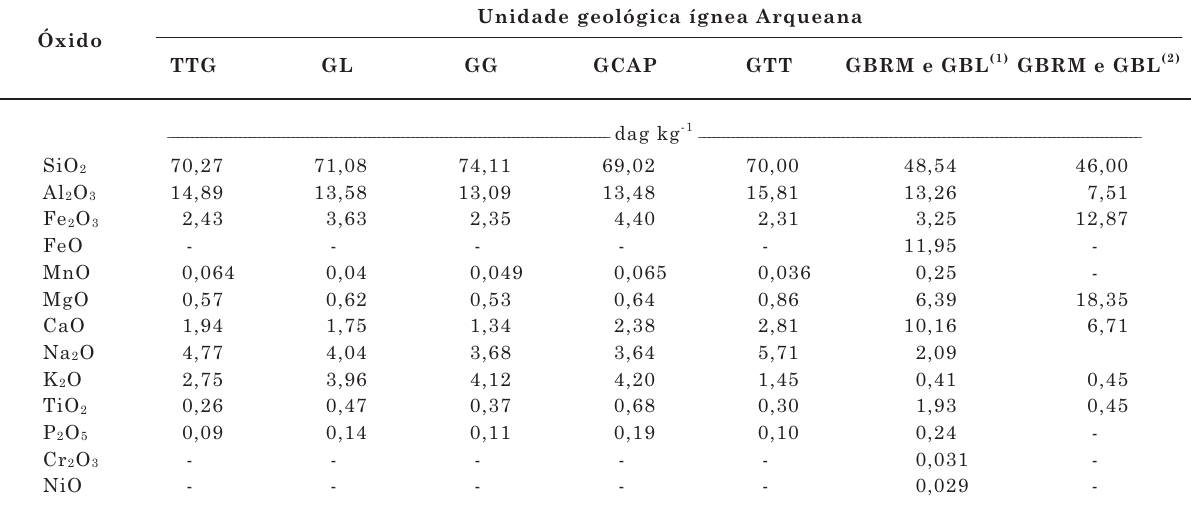
TTG: Gnaisses TTG – Gnaisse Pau da Bandeira; GL: Gnaisse Granodiorítico de Lavras; GG: Gnaisses Graníticos; GCAP: Granulitos Cálcio-Alcalino-Potássicos – Charnockitos; GTT: Granulitos Tonalítico-Trondhjemíticos – Enderbitos. (1) GBRM e GBL: Anfibolitos – Greenstone-belt Rio das Mortes e Greenstone-belt de Lavras. (2) GBRM e GBL: Rochas Ultrabásicas – Greenstone-belt Rio das Mortes e Greenstone-belt de Lavras. Fonte: Quéméneur (1995).